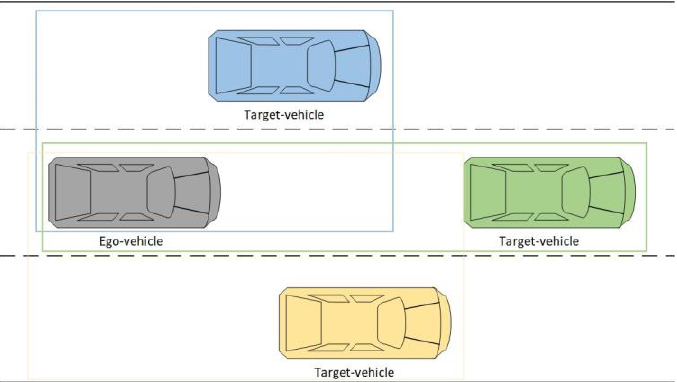
Figure 2. Diagram of case division.